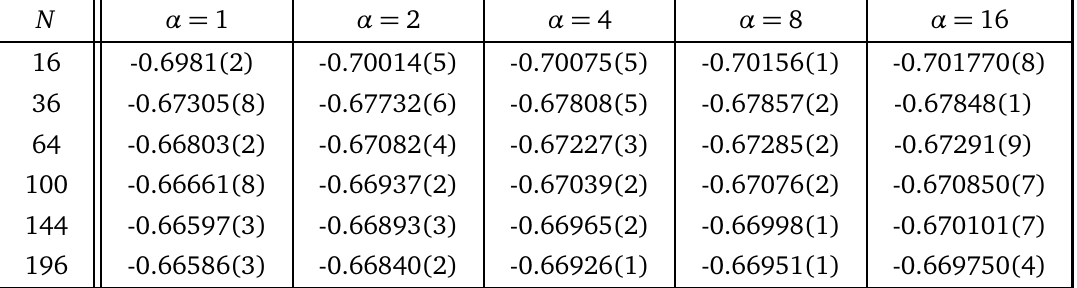
Table 1: Ground state energy for different α and different system sizes. Evaluation of the ground state energy is done sampling 10 5 states. Errors are calculated as statistical errors on the Monte Carlo sampling.